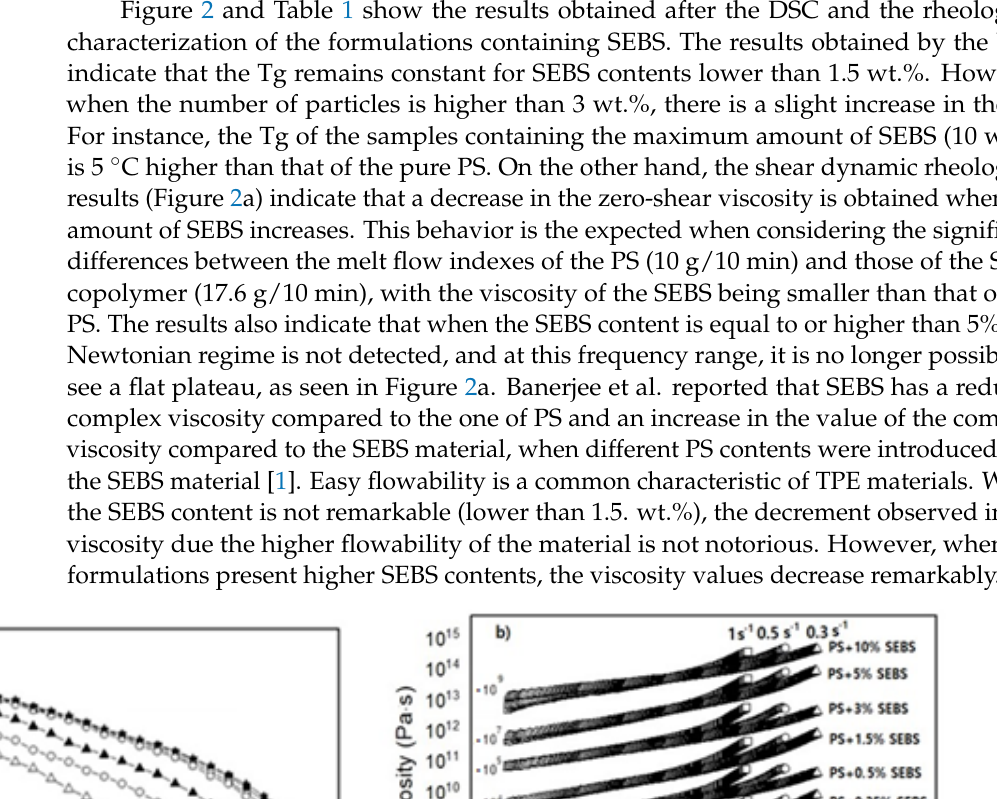
Table 1. Glass transition temperature and shear and extensional rheology properties of the formulations produced.